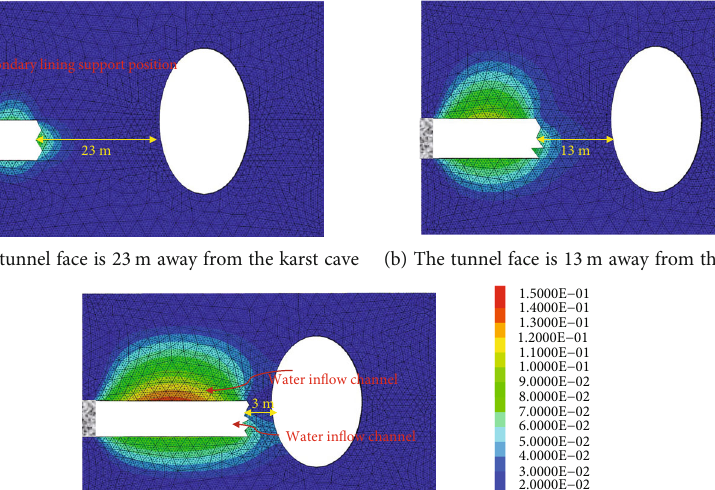
Figure 3. BP neural network is a complex and nonlinear dynamic analysis system, including input layer, hidden layer, and output layer. The network response corresponding to the input mode is transmitted from the input layer to the output layer through the middle layer. According to the error between the actual tunnel displacement value and the numerical simulation value, the connection weight is cor- rected from the output layer to the input layer through the hidden layer so that the di ff erence between the actual value and the expected value is gradually reduced. However, BP neural network has some problems, such as slow conver- gence speed, poor network performance, uncertain learning